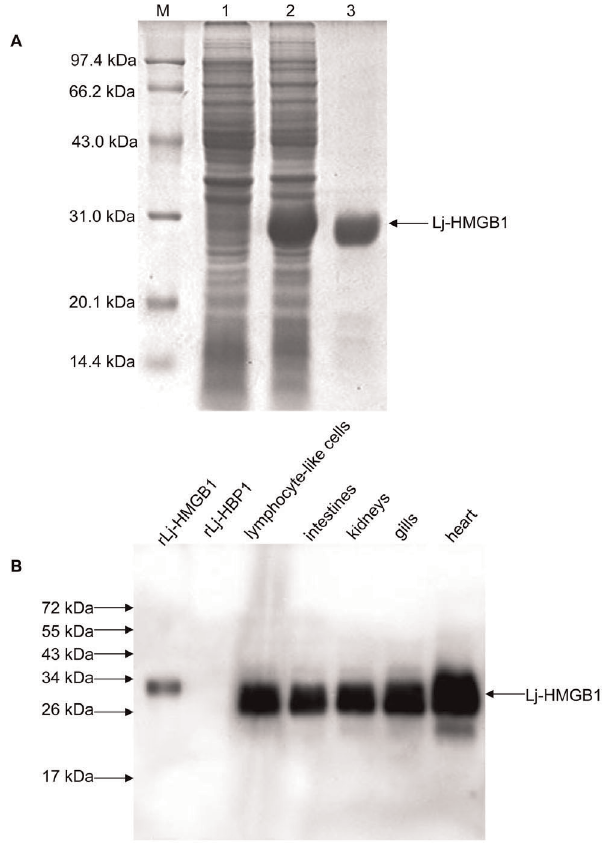
Figure 5. Expression and purification of recombinant Lj- HMGB1. A. SDS-PAGE. Total protein was separated by 12% SDS-PAGE under reducing conditions and stained with Coomassie Brilliant Blue R- 250. Lane M, low molecular weight protein maker; Lane 1, crude lysate pre-induction; Lane 2, crude lysate post-induction; Lane 3, purified rLj- HMGB1. B. Western blot showing the specificity of the anti-Lj-HMGB1 antibody. Purified rLj-HMGB1 and proteins from crude homogenates of various lamprey tissues were probed with a rabbit anti-Lj-HMGB1 antibody. Lane 1, purified rLj-HMGB1; Lane 2, purified rLj-HBP1 (His- tagged negative control); Lanes 3–6, lymphocyte-like cells (lane 3), crude homogenate of the intestines (lane 4), kidneys (lane 5), gills (lane 6) and heart (lane 7) from L. japonica